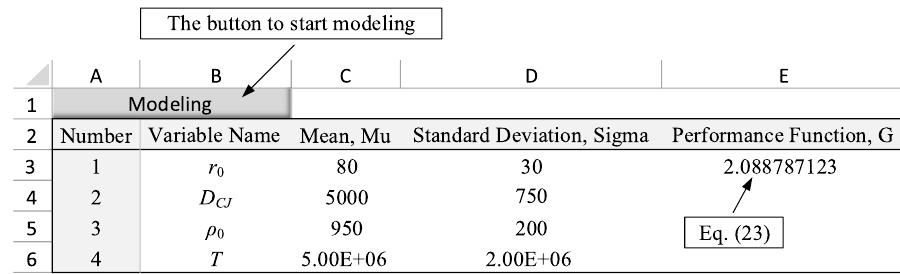
Fig 3. Data entry table in the spreadsheet for the example